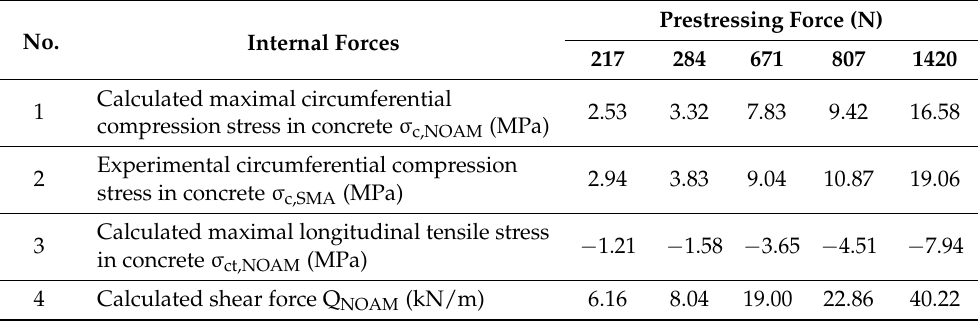
Table 2. Calculated and measured circumferential and longitudinal maximum concrete stress values and maximum cross-section force values in hollow cylinders with external diameter of 250 mm prestressed with Ni-Ti wire.